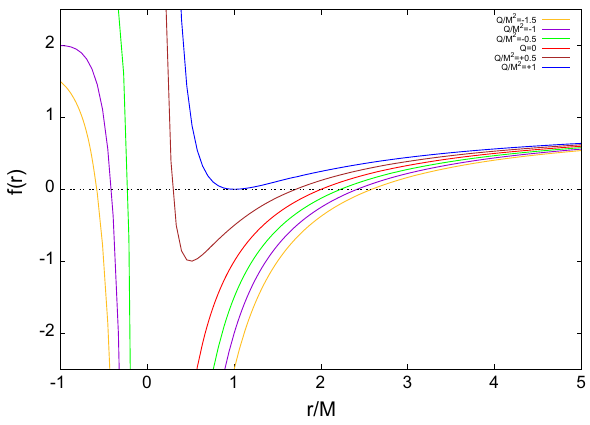
Fig. 1 Horizons of the DMPR brane-world spacetime with a fixed